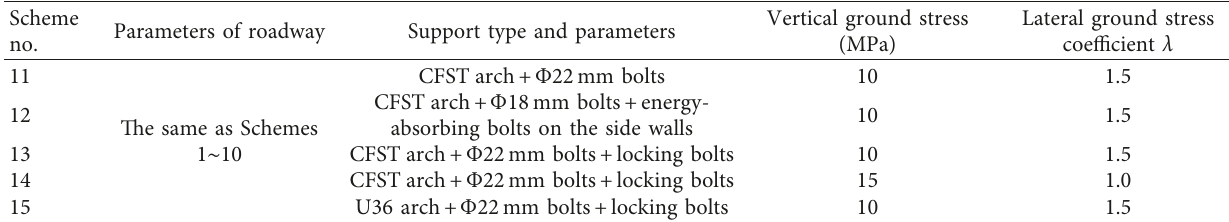
Table 6: The numerical schemes for enhanced support.